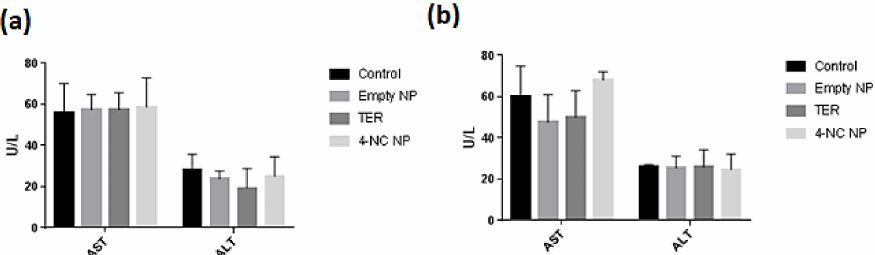
Figure 11. Analysis of the alanine aminotransferase (ALT) and aspartate aminotransferase (AST) enzymes from treated and untreated animals. ( a ) Control, no treatment; TER, free terbinafine; 4-NC NP, Nanoparticles with 4-NC; Empty NP, empty nanoparticles, with 3 days treatment. ( b ) Control, no treatment; TER, free terbinafine; 4-NC NP, nanoparticles with 4-NC; Empty NP, empty nanoparticles, with 7 days treatment. The statistical analysis was performed by Graph Pad Prism Version 7.0 software, through analysis of variance (ANOVA) and Dunnett’s test, establishing p < 0.05 as the significance